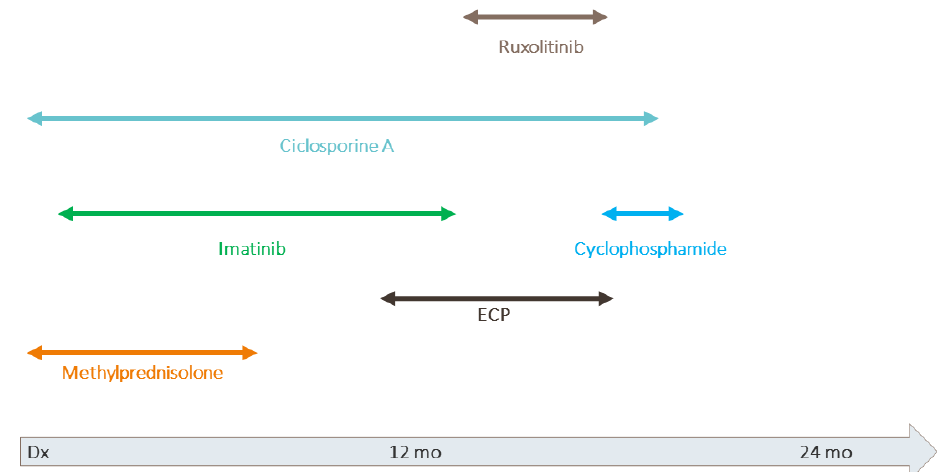
Figure 3. Treatment of cGvHD in case 2.